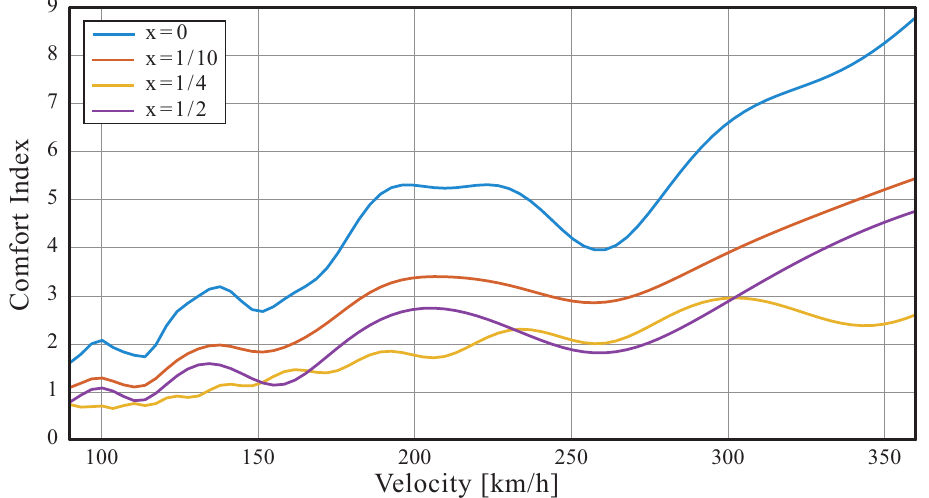
Figure 14. Comfort index at four locations on the beam versus versus speed ( v